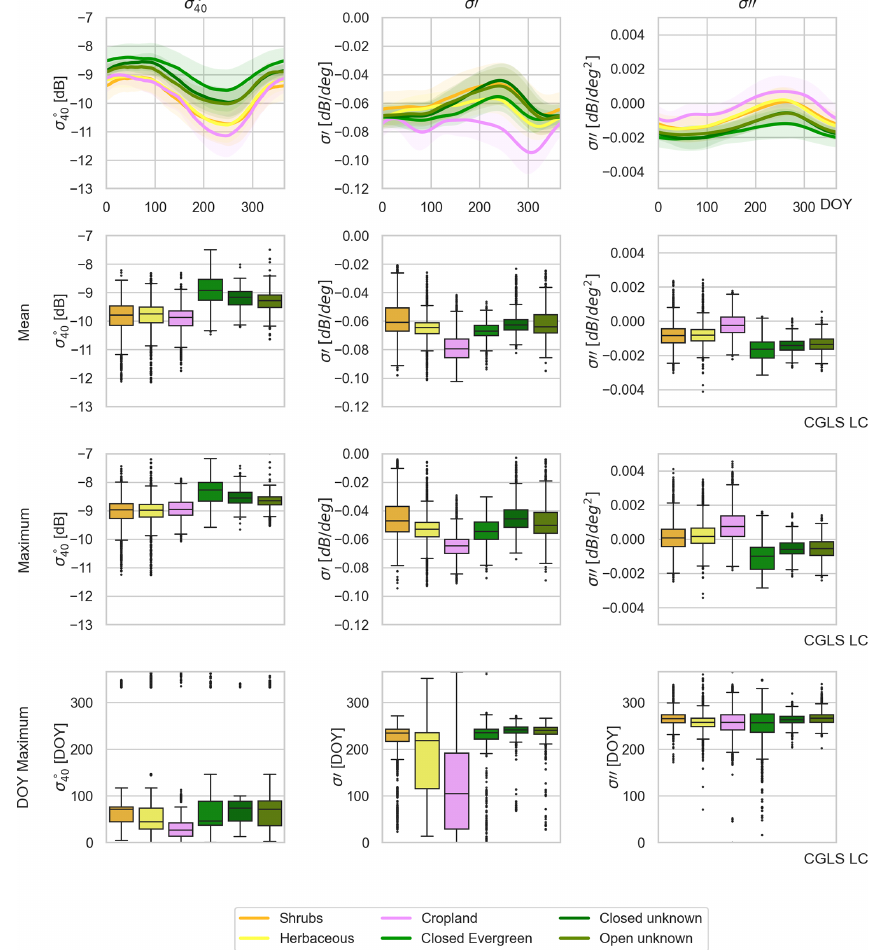
Figure 9. Time series averaged per land cover class and box plots of mean, maximum, and DOY of maximum for backscatter, slope, and curvature over the Cerrado.